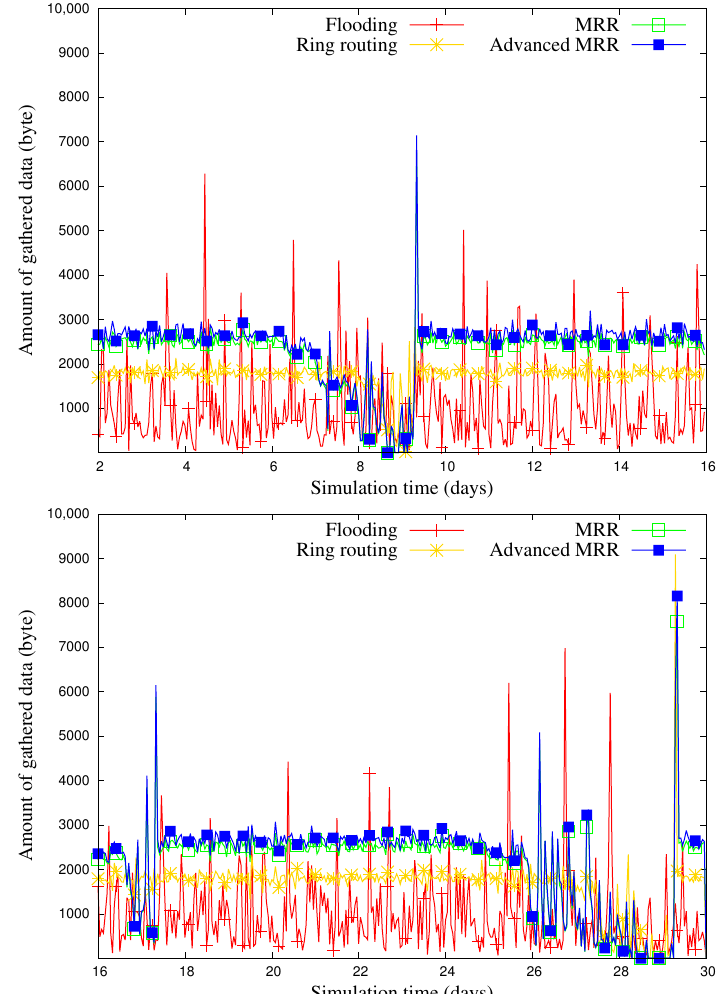
Figure 17. Tracing the amount of gathered data on a sample run out of 50 runs when the number of nodes is 600 (6th ∼ 9th day: rainy, 16th ∼ 17th day: cloudy, 25th ∼ 29th day: rainy, and others: